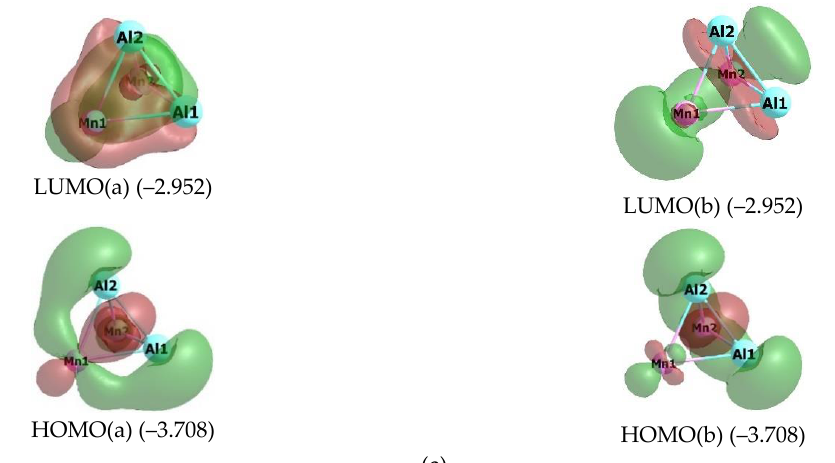
Figure 2. Images of highest occupied (HOMO) and lowest unoccupied (LUMO) molecular orbitals in the Al 2 Sc 2 (3-I) ( a ), Al 2 Ti 2 (3-I) ( b ), Al 2 V 2 (3-I) ( c ), Al 2 Cr 2 (1-I)* ( d ), and Al 2 Mn 2 (1-I)* ( e ) metal clusters. The values of energies of these molecular orbitals (in brackets) are given in eV. The symbol “a” corresponds to electron with spin (+1/2), “b”, to electron with spin–l/2).